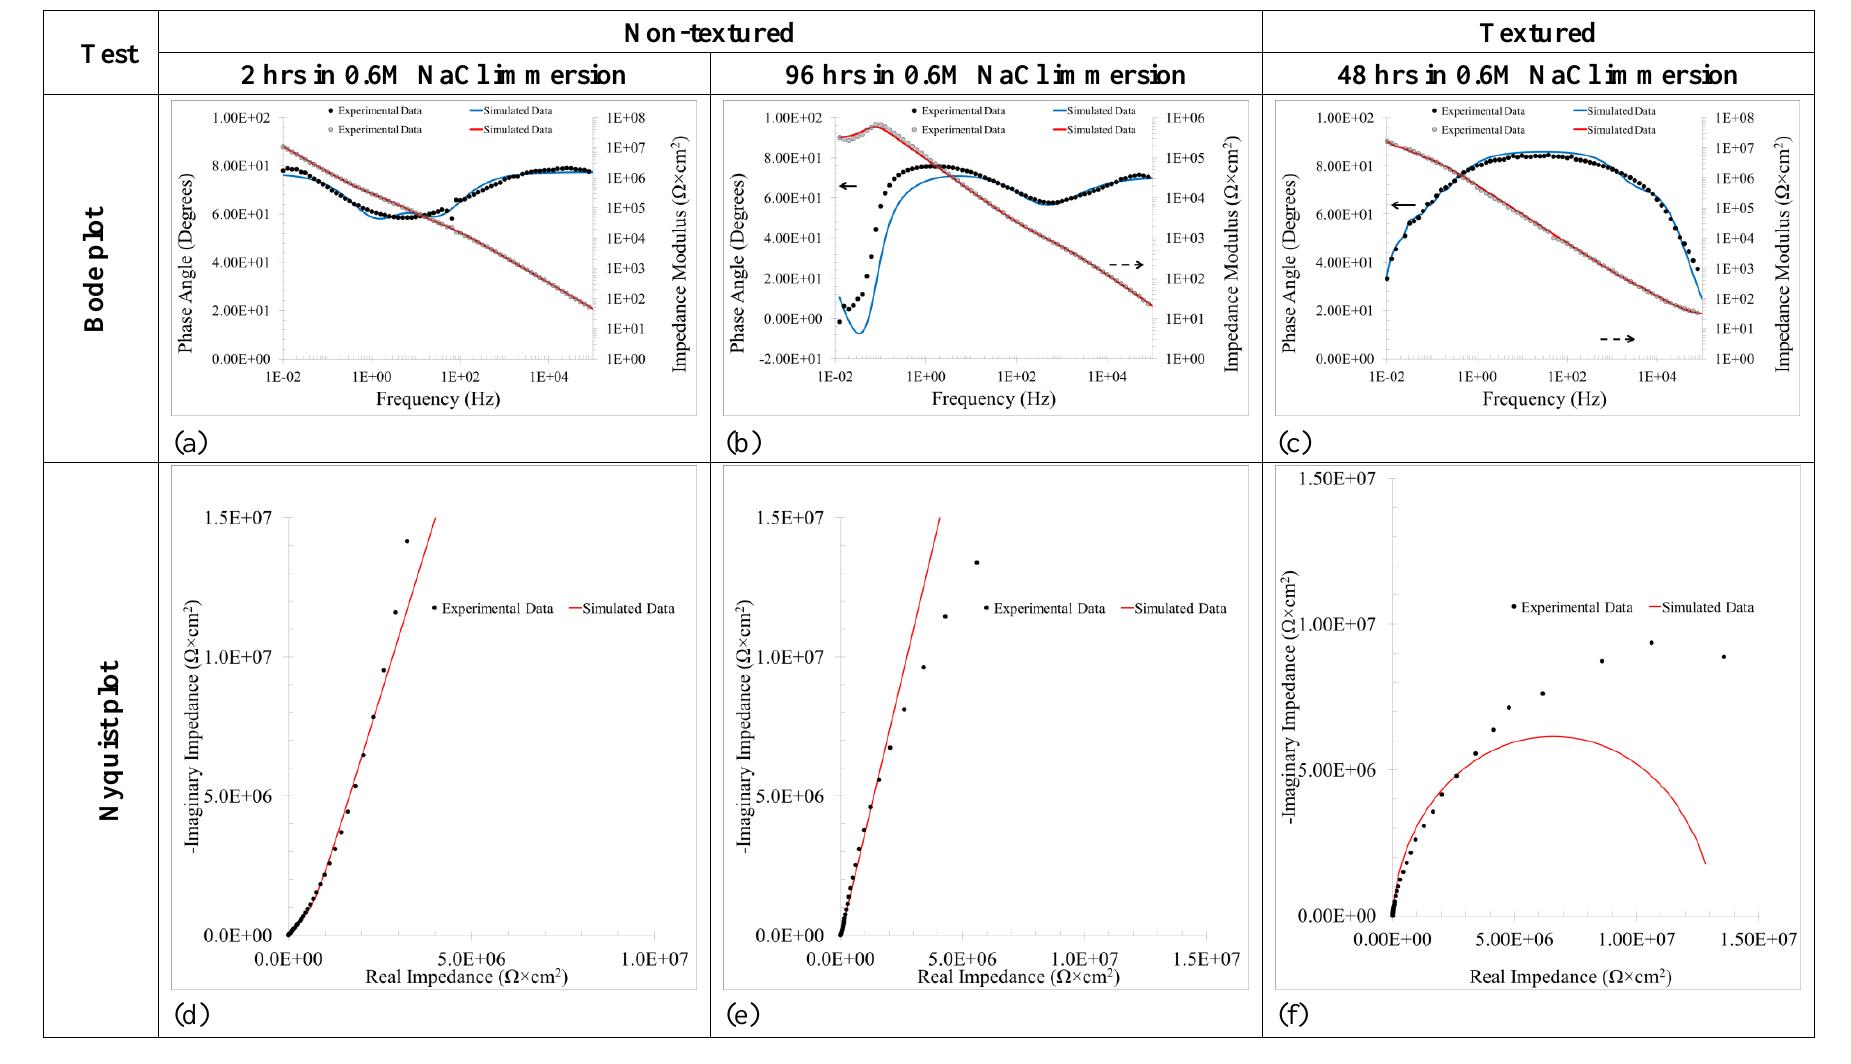
Figure 6. Experimental and simulated Bode and Nyquist plots of the non-textured and textured samples.